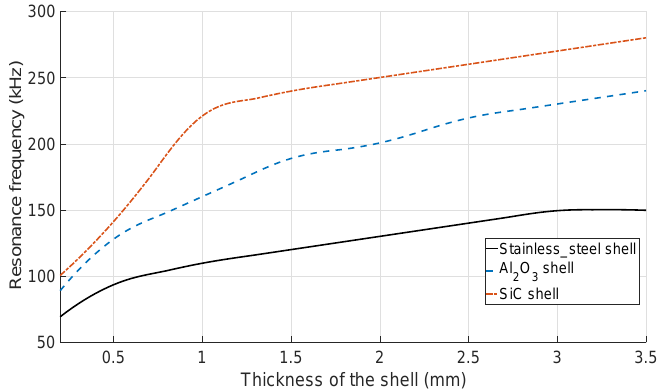
Figure 2. The simulated first mode resonant frequency of the resonating shell transducer with three different shell’s